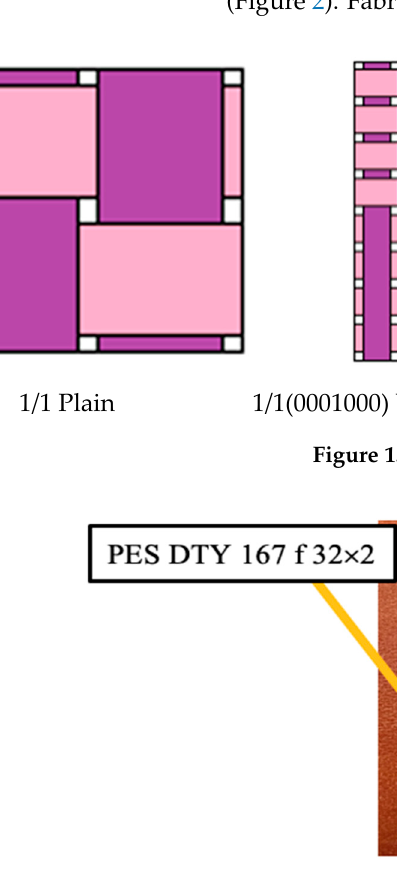
Figure 2. Polyester textured yarn type. Table 1. Type of yarn and fabric parameters set.